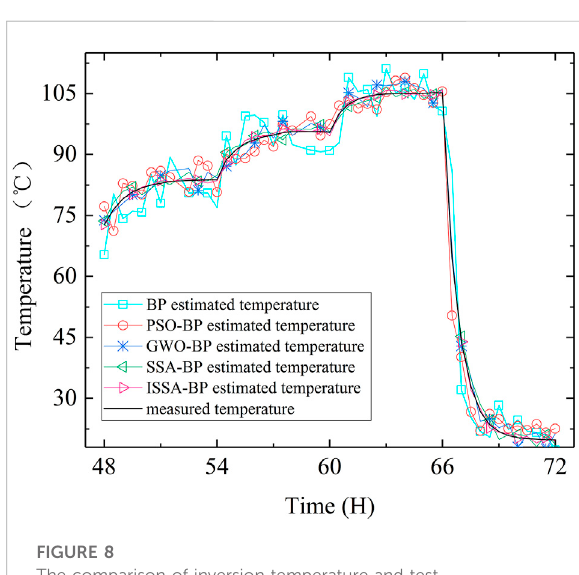
FIGURE 7 Convergence curve of fi tness for four optimization algorithms.